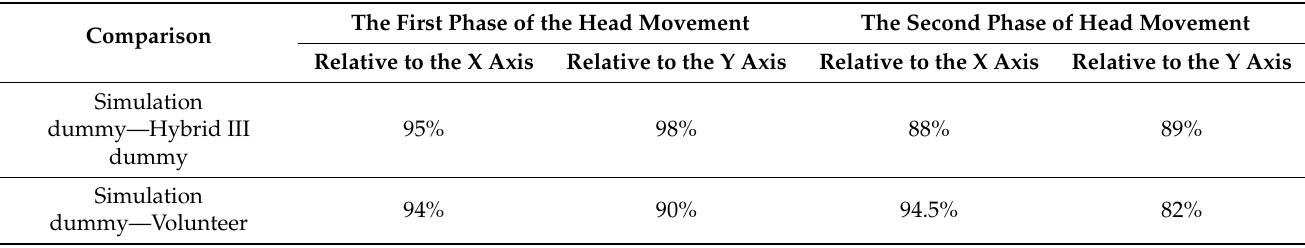
Table 3. Comparison of the accuracy of the dummy head